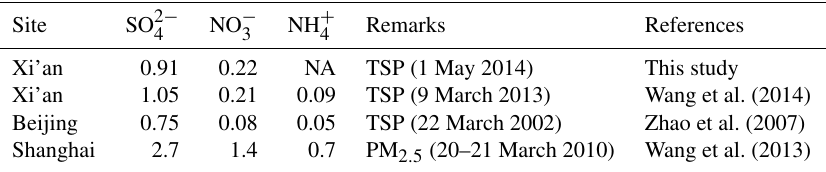
Table 4. The relative amounts (%) of nitrate, sulfate and ammonia in TSP or PM 2 . 5 in postfrontal air during dust storms at downwind Chinese cities.